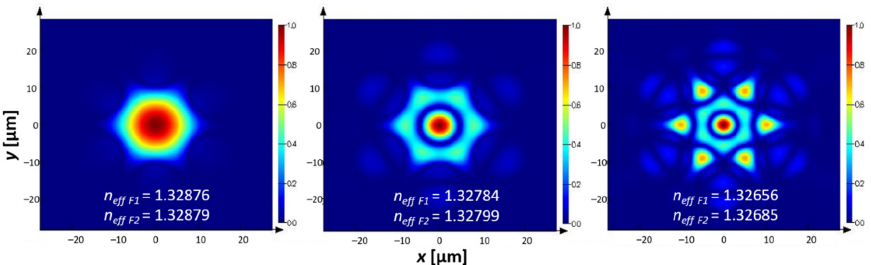
Figure 3. Mode profiles of the first 3 fundamental modes LP01, LP02 for the designed fibers, at the core refractive index n = 1.33. The shape of the presented mode profiles is the same for both F1 and F2, and the small difference in the diameters of both fibers does not influence this. The circular symmetry of all modes is clearly visible, satisfying the condition for efficient coupling between them [5]. Their effective refractive indices for the F1 and F2 fibers are also additionally presented.